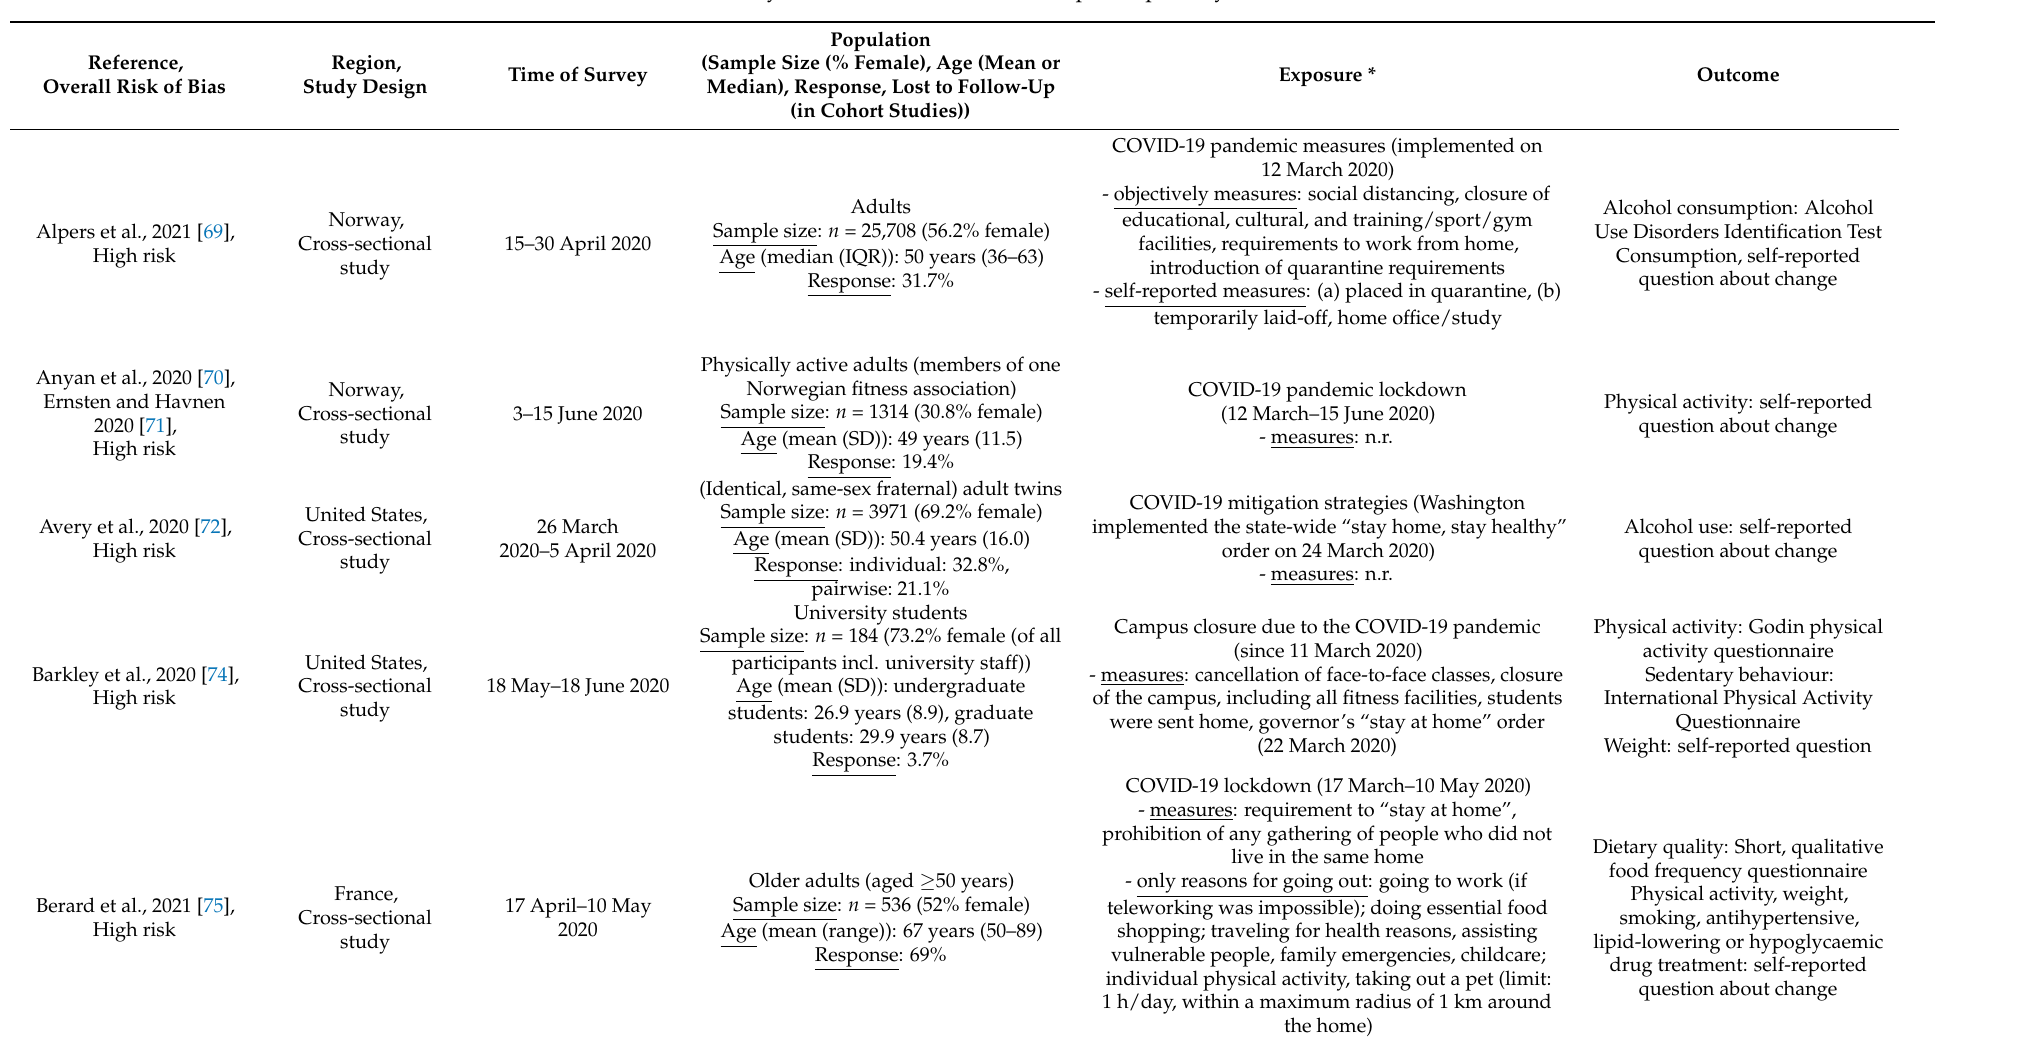
Table 2. Study characteristics of COVID-19 specific primary